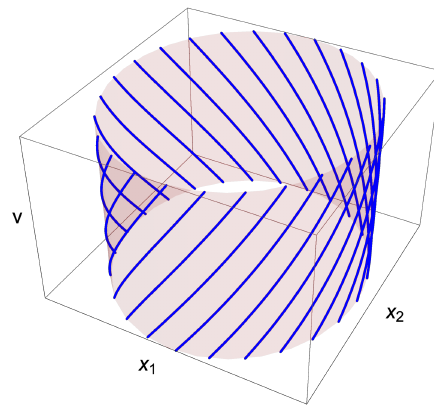
Figure 1 . Source pro(cid:12)le for the round NS5-P supertube, with n 5 = 25 and k =